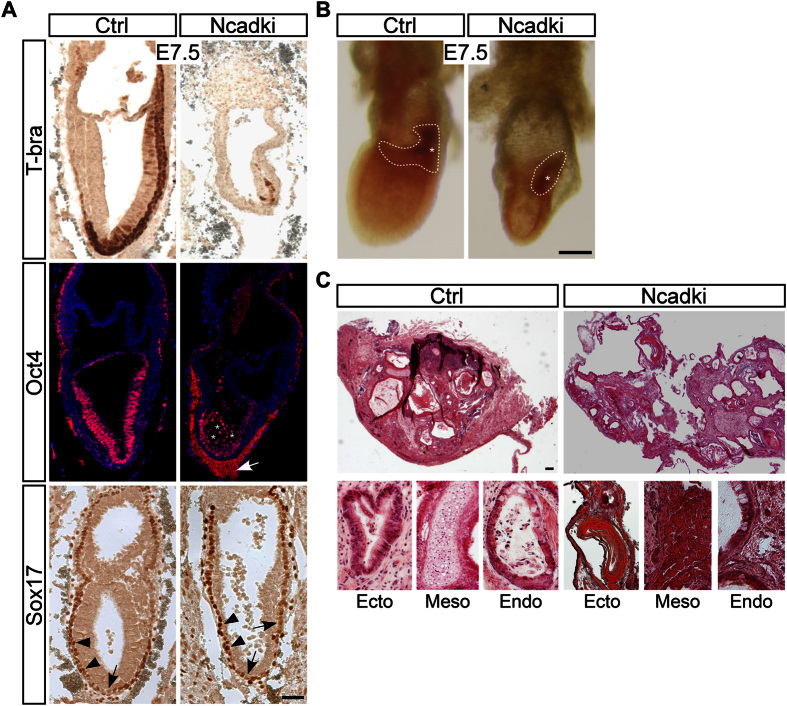
Ncadki embryos properly initiate gastrulation and cells retain their full differentiation capacity.(A) Immunohistochemistry and immunofluorescence labeling of key markers of ectoderm (Oct4), mesoderm (T-brachyury, T-Bra) and DE (Sox17). Asterisks indicate Oct4-positive detaching cells, arrowheads highlight the intercalating DE cells with increased Sox17 expression and arrows the VE cells. Note that the cell free area between the Reichert’s membrane and VE of Ncadki embryos shows high amounts of unspecific staining for antibodies raised in mice (arrow). Scale bar represents 50 μm. (B) Alkaline phosphatase staining to detect primordial germ cells (PGCs). White dashed lines indicate the area of PGCs which is present but smaller in Ncadki embryos. Embryos are presented with proximal to the top and anterior to the left. Asterisks highlight the PS spot of germ-cell formation. Scale bar represents 100 μm. (C) Overview of H&E stained sections of teratomas generated by transplantation under the kidney capsule with examples of derivatives of ectodermal, mesodermal and endodermal origin in higher magnification. Scale bar represents 50 μm.